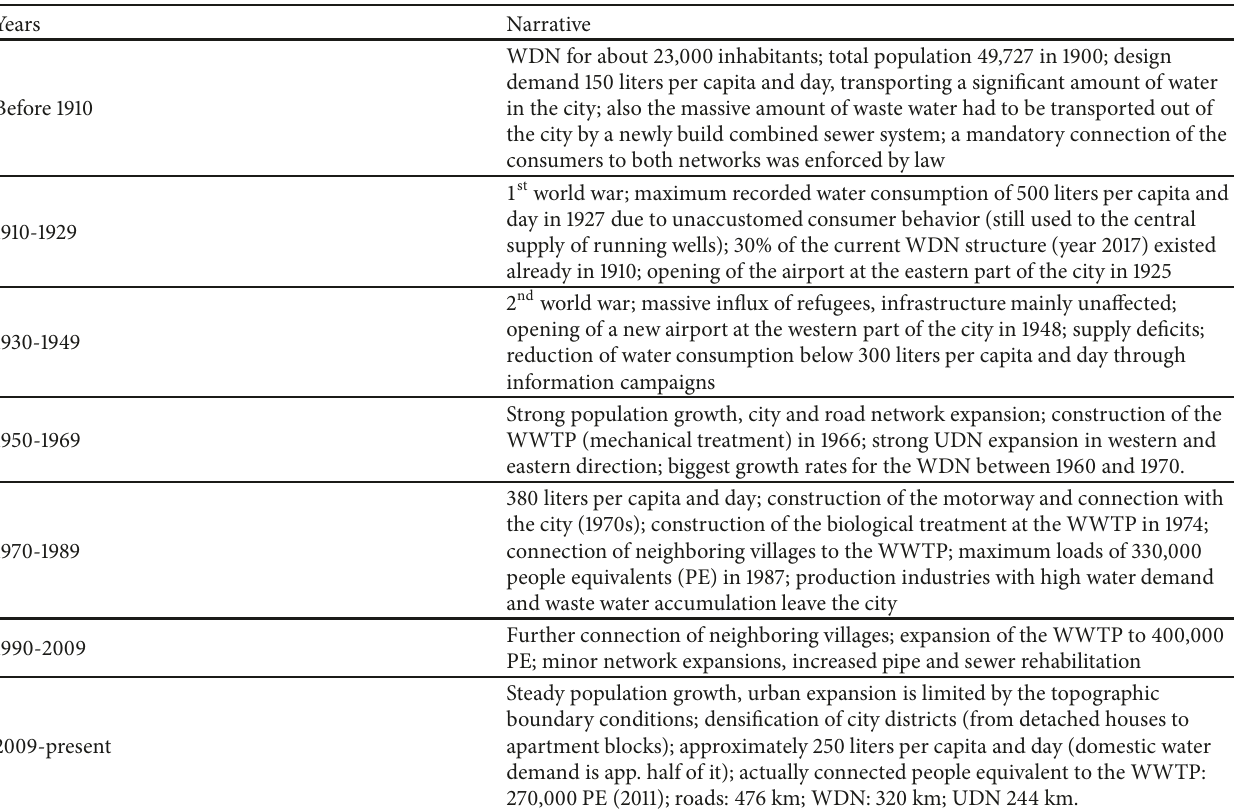
Table 1: Narrative changes of the infrastructure networks